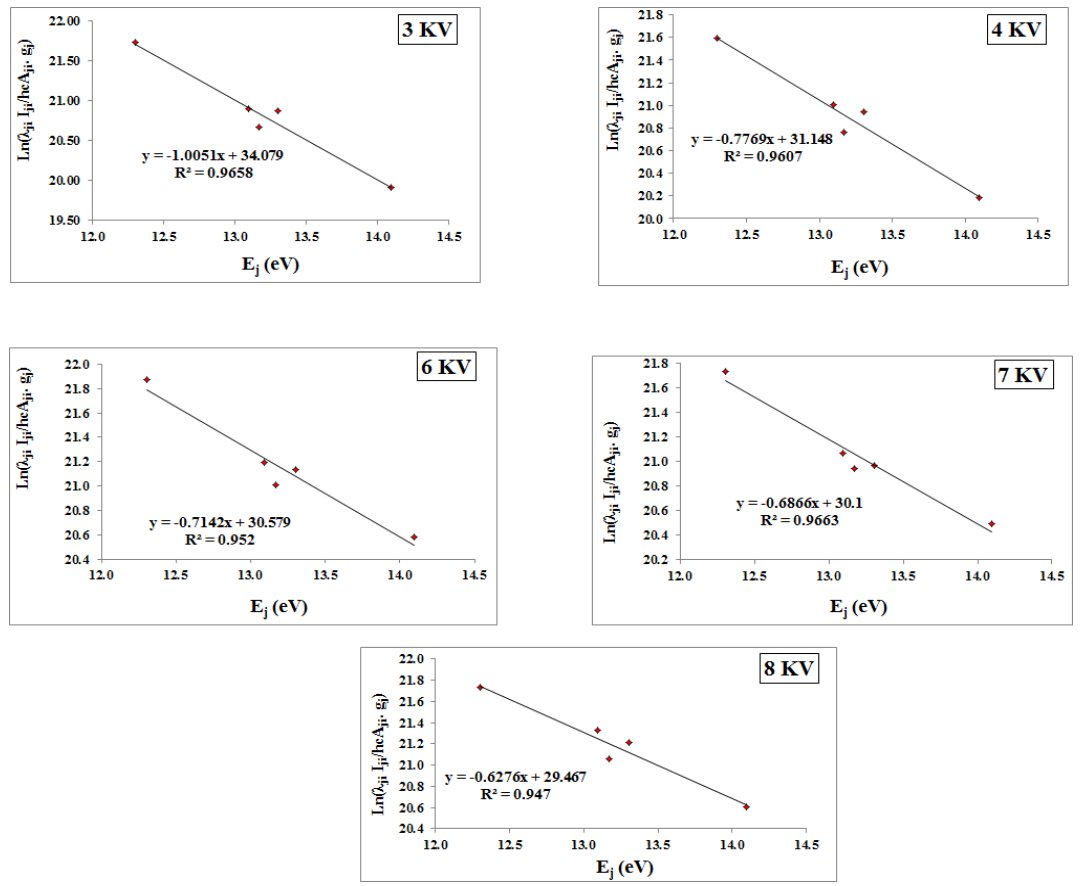
Figure 5: The electron density and electron temperature for the produced plasma using different voltages in the range (3- 8 kV). Table 1: Plasma parameters for the different